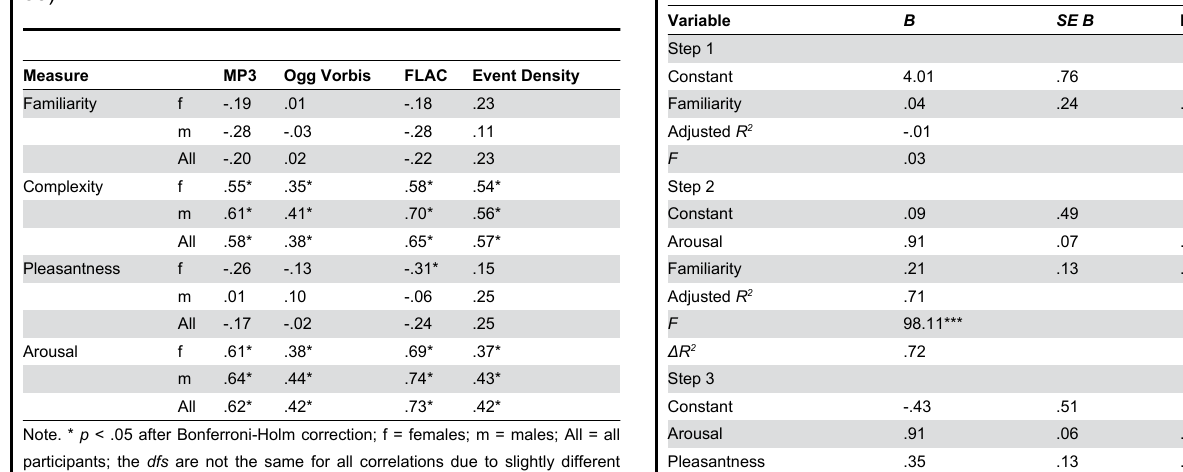
Table 11. Spearman’s rank-order correlations between compression algorithms applied to excerpts of piano solo music, their event density and rated familiarity, complexity, pleasantness and arousal (N 83).